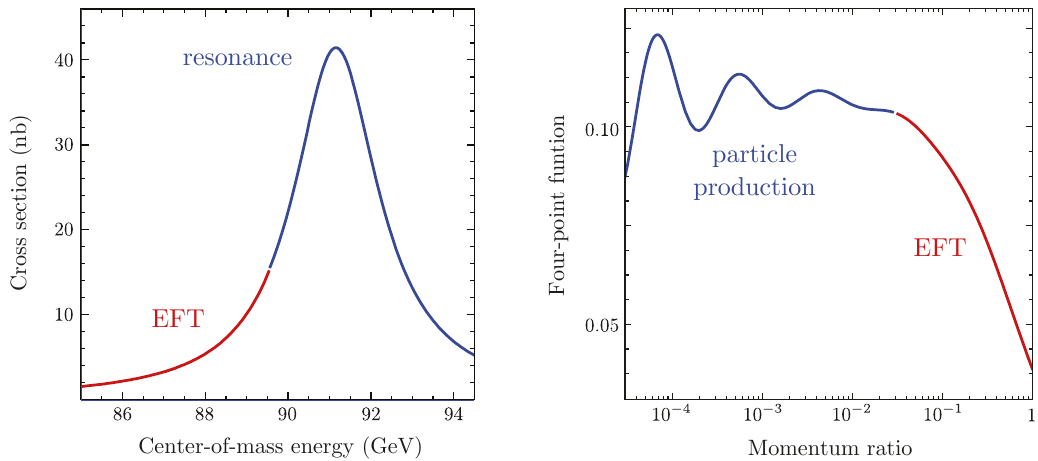
Figure 10. Plot of R energy ((cid:12)gure adapted from [114]).